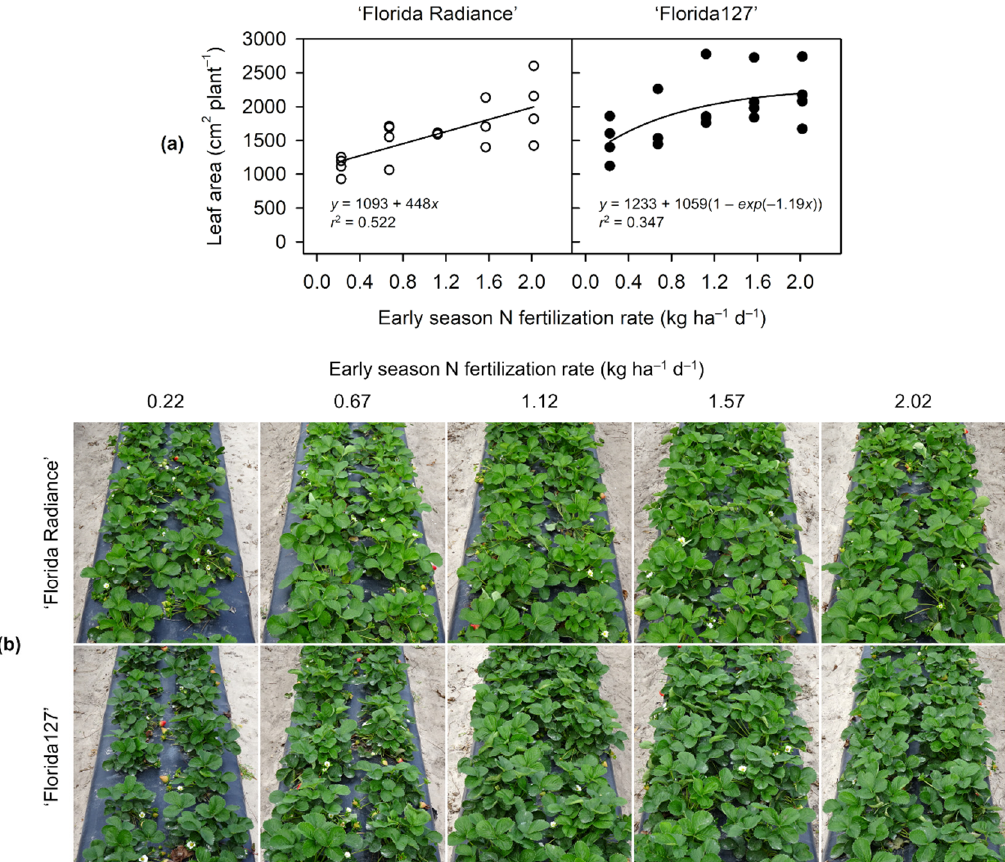
Figure 1. Leaf area growth responses of two strawberry cultivars to different early-season nitrogen (N) fertilization rates in the 2014–2015 growing season: ( a ) the best-fit model; ( b ) overhead canopy images. Leaf area data and images were collected on 13 January 2015. Treatments are as described in Table 2. Five models were fit to each data set: linear, quadratic, exponential plateau, exponential decay, and sigmoidal models. Only the significant ( p ≤ 0.05) and best-fit model is shown for each data set.